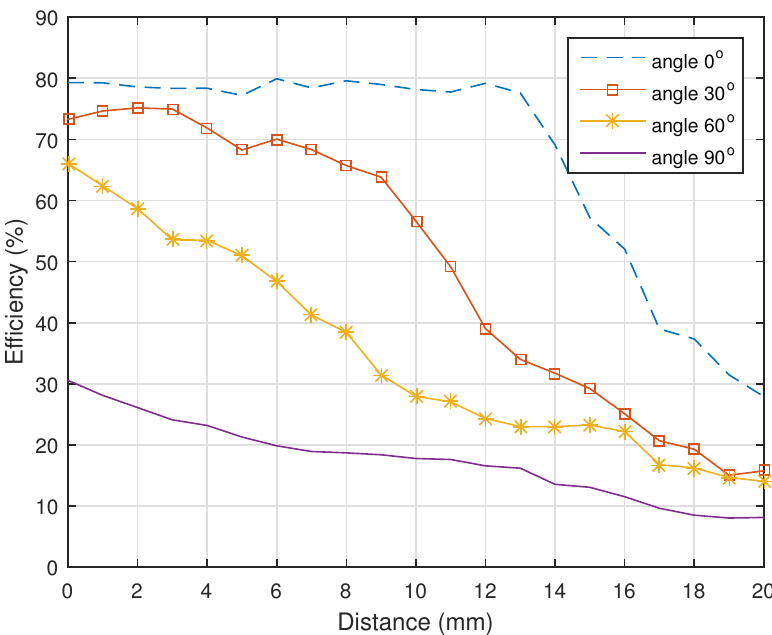
Figure 14. Measured angle efficiency of the combined system for various angles between transmitter and